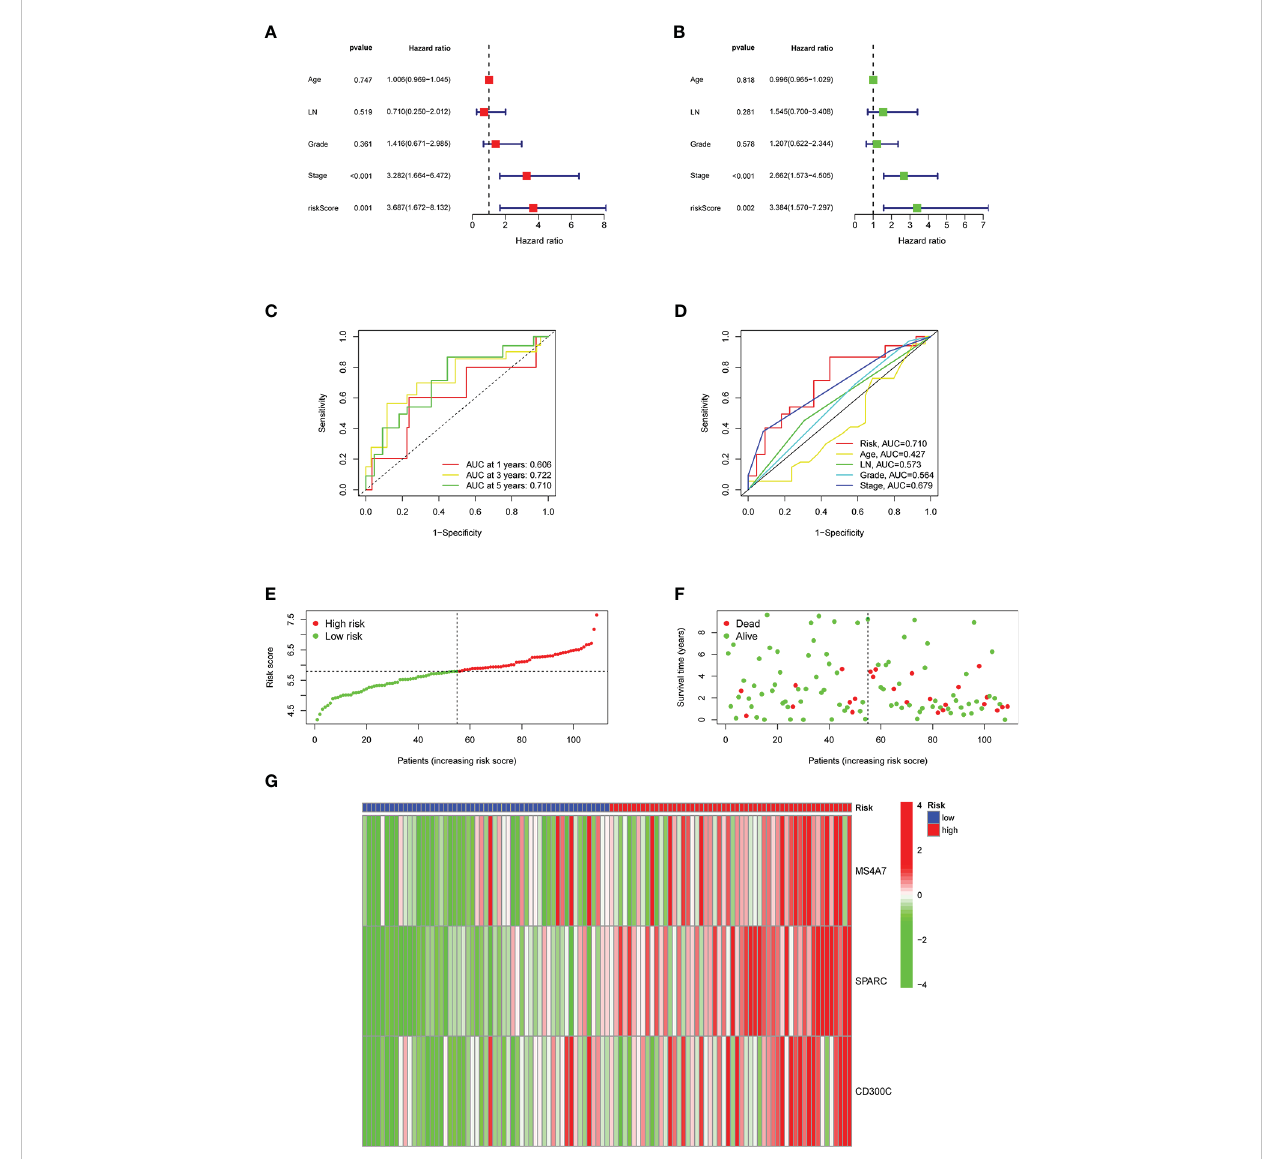
FIGURE 6 Results of the risk classi fi cation and veri fi cation analysis as independent factors: A shows the results of univariate analysis, B shows the results of multivariate analysis, C shows the ROC curve using risk score as a single factor, D shows the ROC curve using risk score as one of the multiple factors, E shows the results of division of high- and low-risk groups, F shows the results of survival condition analysis, G shows the expression results of MS4A7, SPARC, and